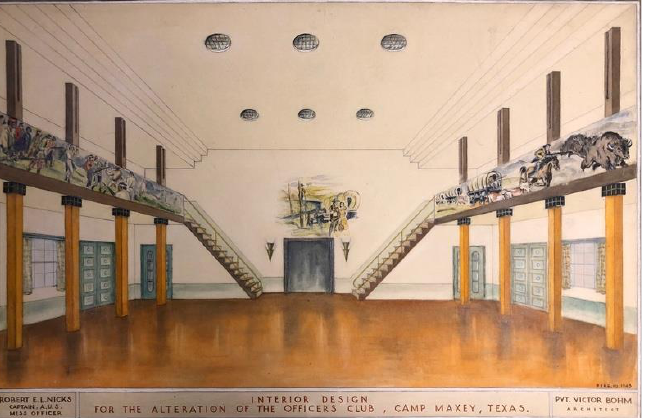
Figure 18. Interior design of the officers club (associated art: murals and interior design). Designer: Victor Bohm, 1943. Source: Linda Bohm’s personal archive.